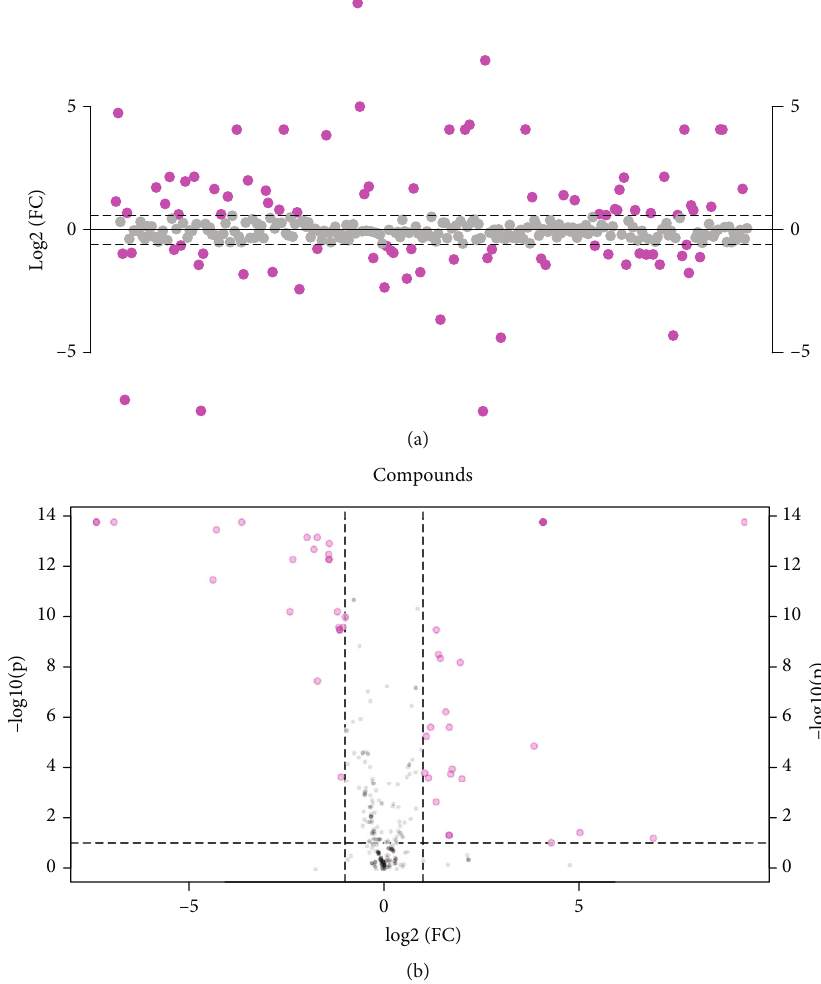
Figure 5: The characteristics and correlation of serum metabolites. (a) The di ff erent metabolites associated with CHF were con fi rmed ( log 2 ð FC Þ > 1 : 0 ) (pink). (b) Volcano map showed the di ff erent metabolites in CHF and healthy